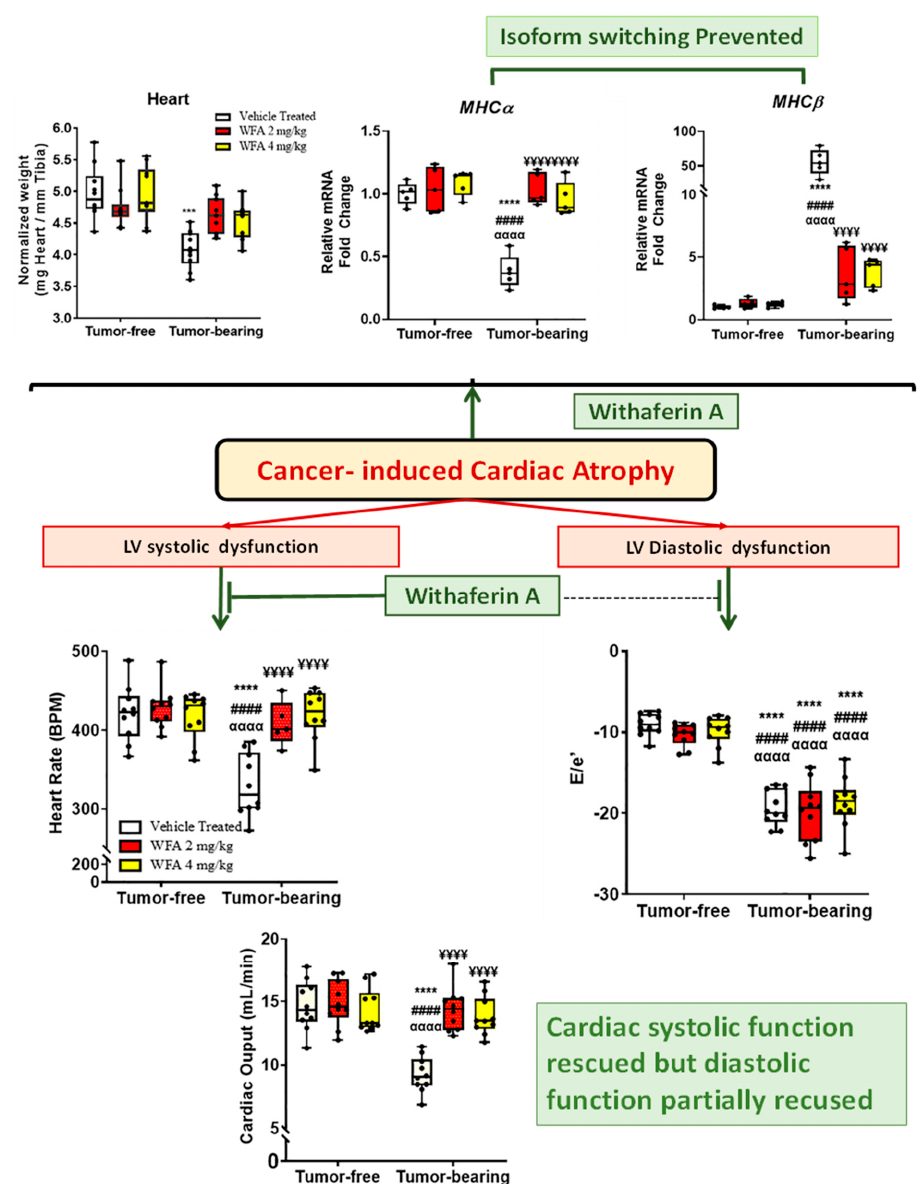
Figure 5. Effect of Withaferin A (WFA) on the reversal of cardiac cachexia induced by cancer. Reversal of cardiac systolic functions by Withaferin A in the form of reversal of heart weight, left ventricular heart rate, fractional shortening, cardiac output and left ventricular mass, cross-sectional area of cardiomyocytes (not shown), and partial reversal of diastolic function (E/A ratio, E/e’ ratio, IVRT: isovolumetric relaxation time), and shift in MHC isoforms) through the decrease in angiotensin II and proinflammatory cytokines levels in an NSG mice tumor model. *** p < 0.001; **** p < 0.0001 indicates a significant difference from the corresponding value of the tumor-free vehicle-treated group by two-way ANOVA followed by Tukey’s multiple comparison test, #### p < 0.0001 indicates a significant difference from the corresponding value of the tumor-free WFA 2 mg/kg group, αααα p < 0.0001 indicates a significant difference from the corresponding value of the tumor-free WFA 4 mg/kg group. ¥¥¥¥ p < 0.0001 indicates a significant difference from the corresponding value of the tumor-bearing vehicle-treated group. Adopted from reference [18]. Reproduced under Attribution License (CC BY